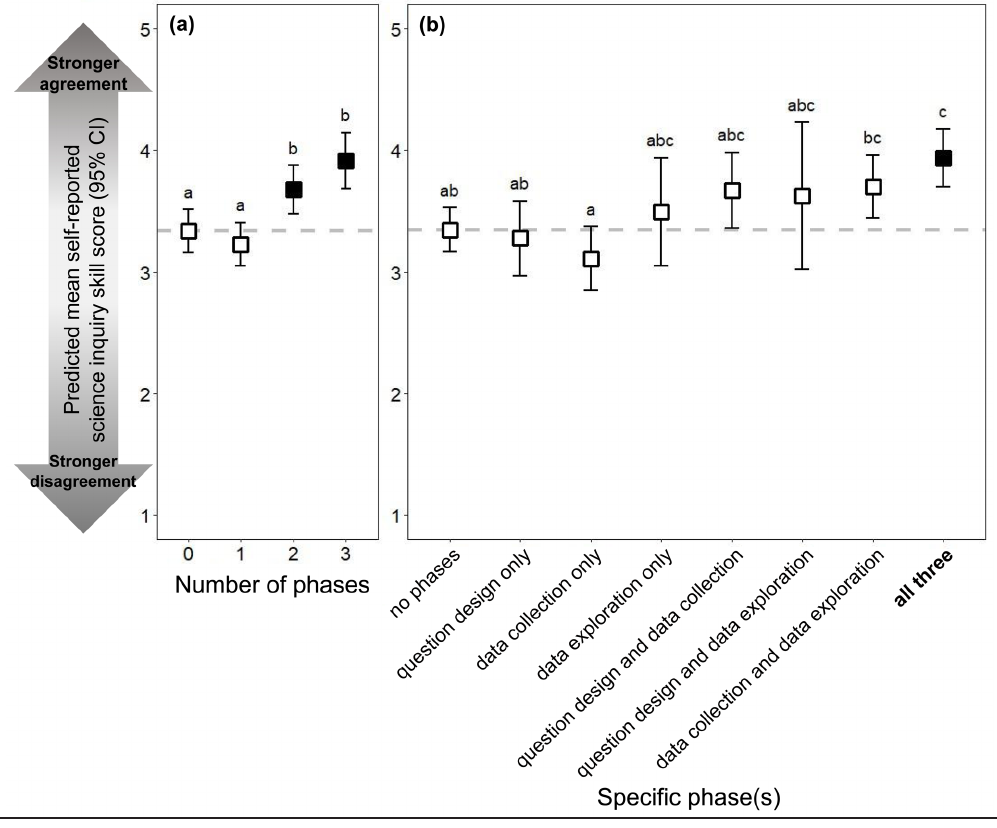
Figure 6 The predicted mean self-reported science inquiry improvement scores (a) increased the more phases in which a respondent participated, and (b) no one phase was associated with greater increases. Each point is the EMM scores with 95% CI. Means not sharing any letter are statistically significantly different from other means by the t-test adjusted using the Tukey method. The horizontal dashed line represents the score for those who did not participate at all, and black squares indicate which values are statistically significantly different to the baseline (“no phases”). The range on the y-axis reflects the range of values in the post-survey